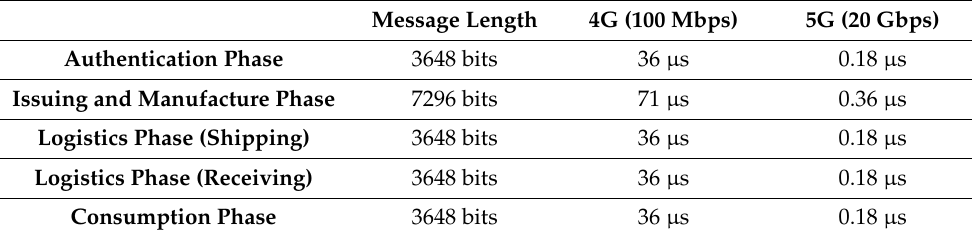
Table 5. Communication costs of the proposed scheme.